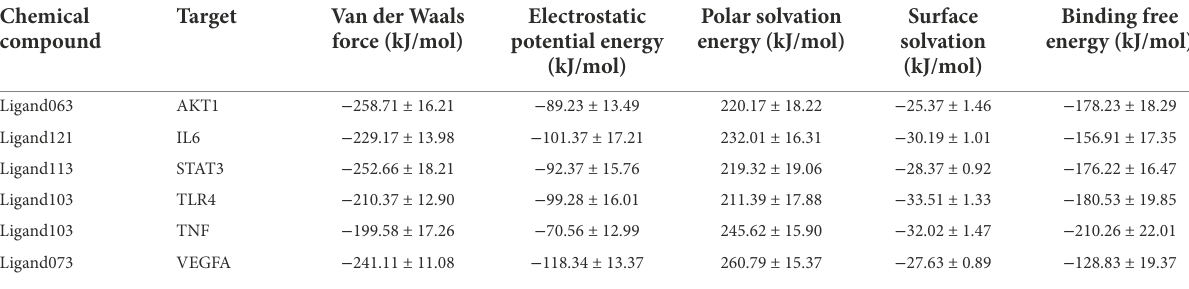
TABLE 3 MM/GBSA of the best candidate compounds and protein targets for each